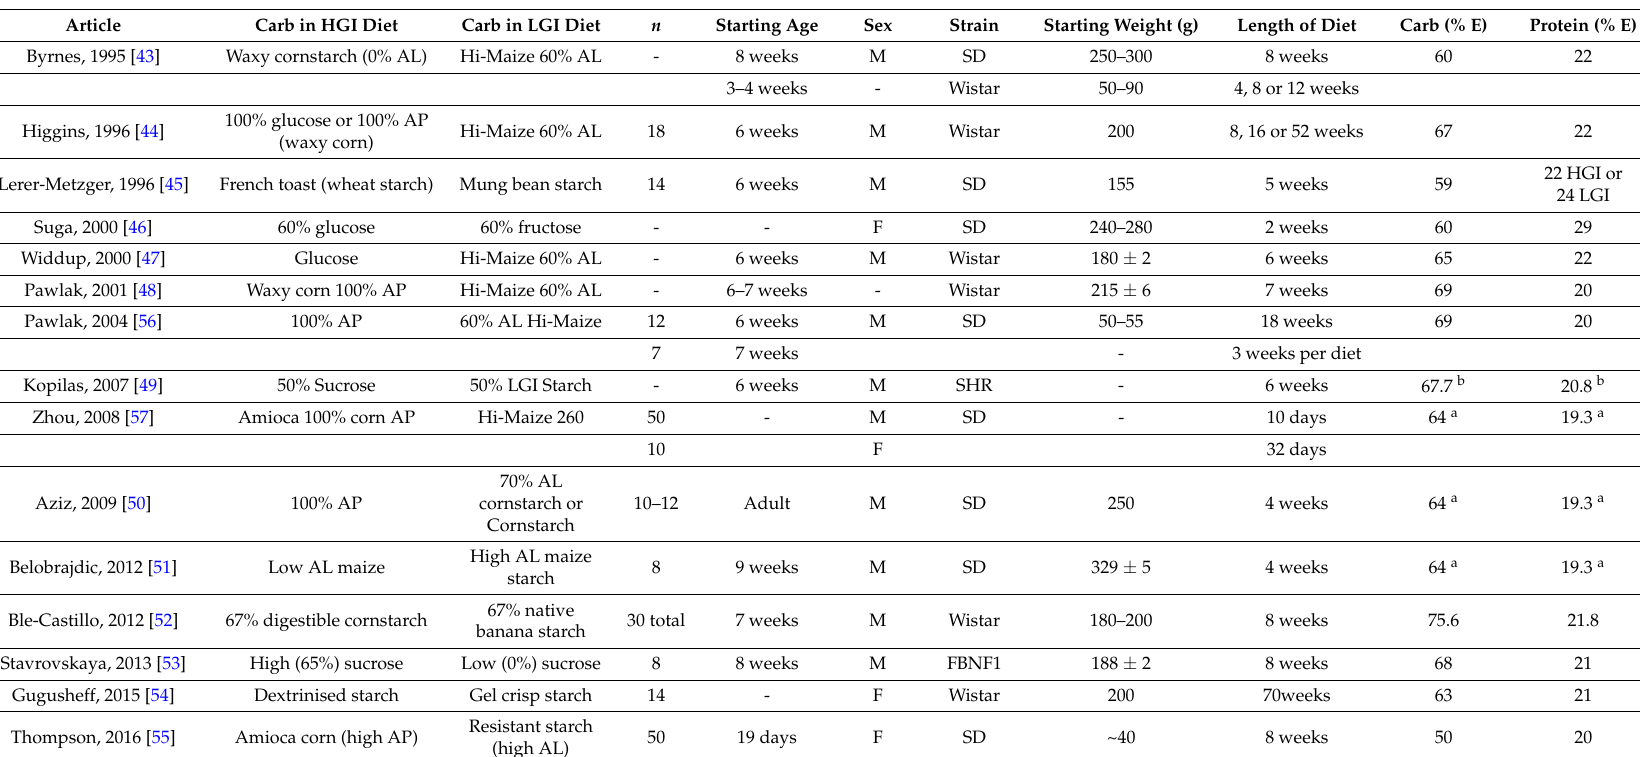
Table 5. Rat animal and diet characteristics for intervention studies that compared LGI and HGI diets. The key information from each article using rats is shown. - denotes missing data. Approximate (~) starting weights are taken from graphs. Articles using two different strains or sexes are across two rows, with the defining characteristics in bold. Only new information is entered in the second row. Carb, carbohydrates; HGI, high glycaemic index; LGI, low glycaemic index; E, energy; n , sample size; SHR, spontaneously hypertensive rats; AL, amylose; M, male; SD, Sprague-Dawley; AP, amylopectin; F,